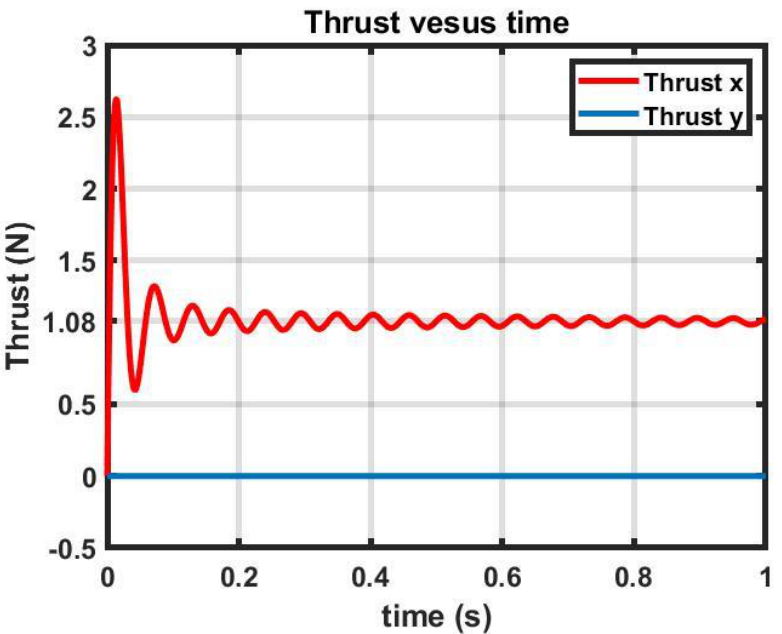
Table 5. some of the key characteristics of analytical calculation and 2-D transient FEM.